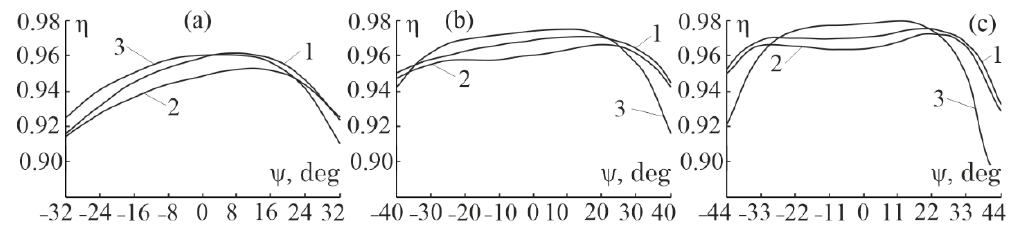
Figure 3. The calculated DE dependence on the angle of incidence for microstructures No. 5 of Table 1. At λ = 0.4 μ m (1); at λ = 0.6 μ m (2); At λ = 0.8 μ m (3). ( a – c ) correspond to P = 10, P = 20 and P = 30.